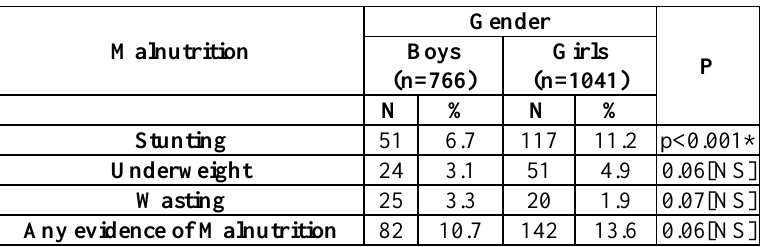
Table 4: Prevalence of malnutrition according to